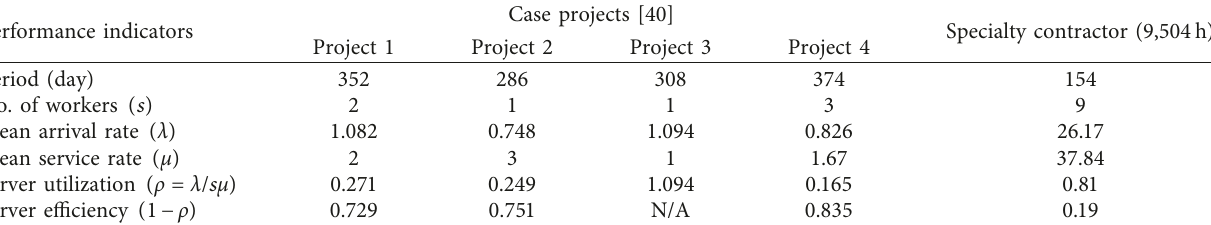
Table 6: Comparison of performance indicators in the queuing